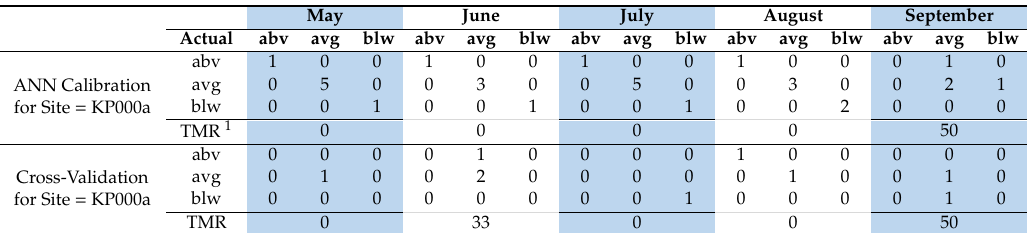
Table 4. Confusion matrices from artificial neural network (ANN) calibration and cross-validation, showing actual and predicted class membership for the months May through September for site KP000a. AGFM classes are above average (abv), average (avg), and below average (blw) above-ground forage biomass. The total misclassification rate (TMR) for each month is also shown, and is calculated as the number of misclassifications divided by the total number of observations.